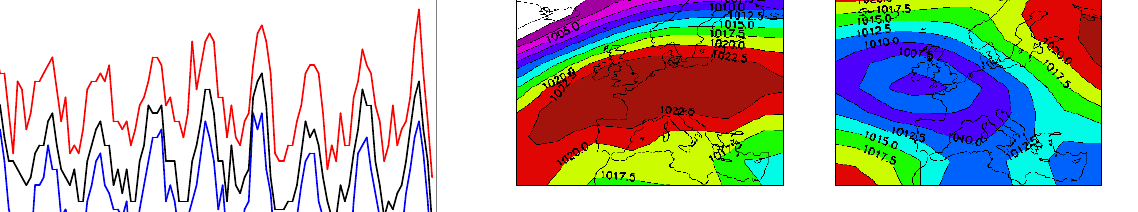
Figure 6. Reconstruction of monthly sea level pressure fields in Europe in March 1779 (left) and in April 1782 (right) (Luterbacher et al., 2002). Fig. 6. Reconstruction of monthly sea level pressure fields in Eu- rope in March 1779 (left) and in April 1782 (right) (Luterbacher et al.,